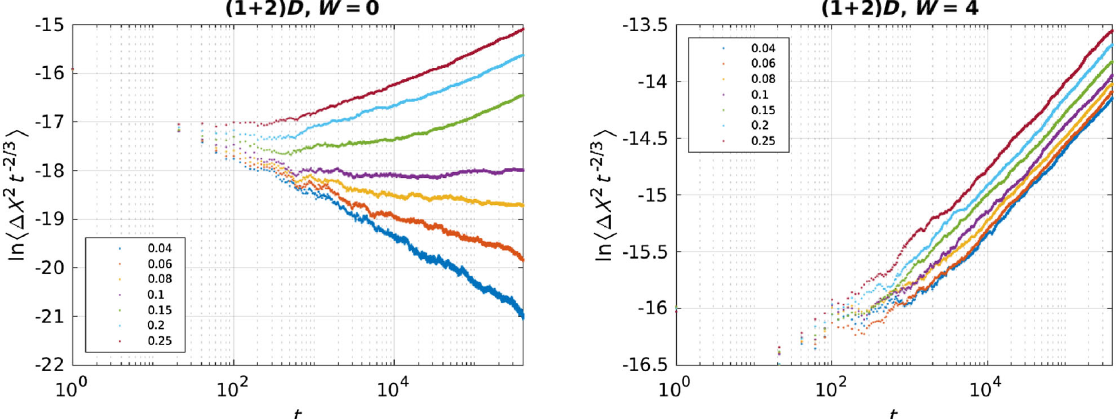
FIG. 2. Spread of the quantum walker as a function of time steps for the two protocols and different values of bandwidth w introduced in Eq. (14). To facilitate observation of the metal-to-insulator transition, the width of the wave packet is rescaled by the critical scaling at the transition, h Δ X 2 i ∼ t 2 = 3 . Left panel: topologically trivial protocol, W ¼ 0 , which shows a metal-to-insulator transition for w ≃ 0 . 1 . Right panel: topological nontrivial variant, W ¼ 4 , which shows no signatures of localization, i.e., h Δ X 2 i ∼ t for all values of w and up to t ∼ 5 × 10 5 time